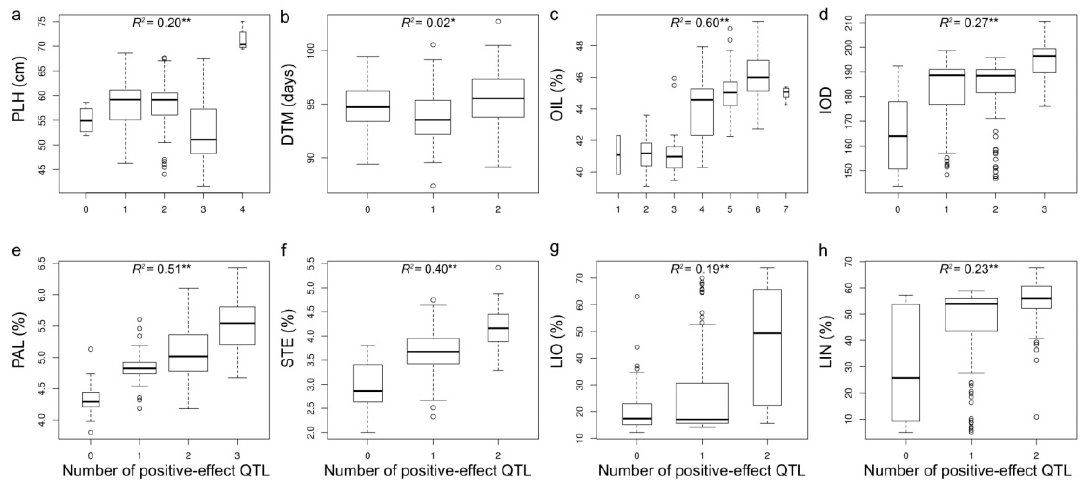
Figure 5. The relationship of phenotypes with the number of positive-effect QTL in individuals. Eight traits with two or more QTL identified were analyzed: ( a ) plant height (PLH), ( b ) days to maturity (DTM), ( c ) oil content (OIL), ( d ) iodine value (IOD), ( e ) palmitic acid content (PAL), ( f ) steric acid content (STE), ( g ) linoleic acid content (LIO), and ( h ) linolenic acid content (LIN). The BLUP values of the eight traits in the merged population were used. The correlation of phenotypes with the number of positive-effect QTL was calculated. * and ** represent statistical significance at 0.05 and 0.01 probability level.